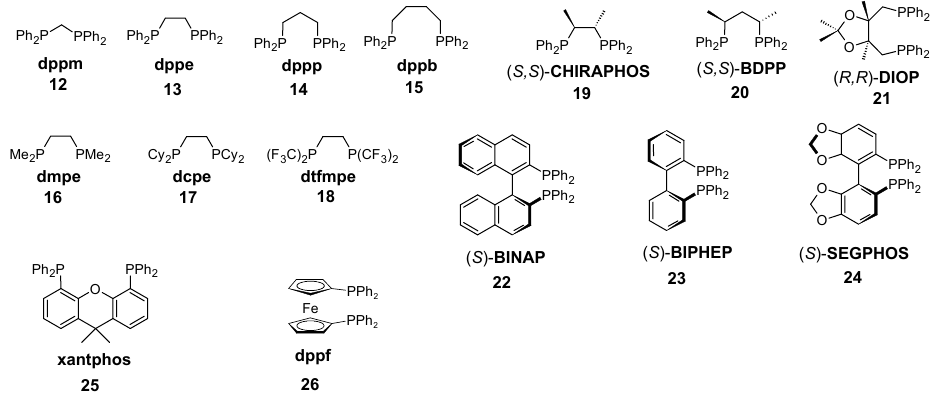
Figure 1. Chelating phosphines considered in this